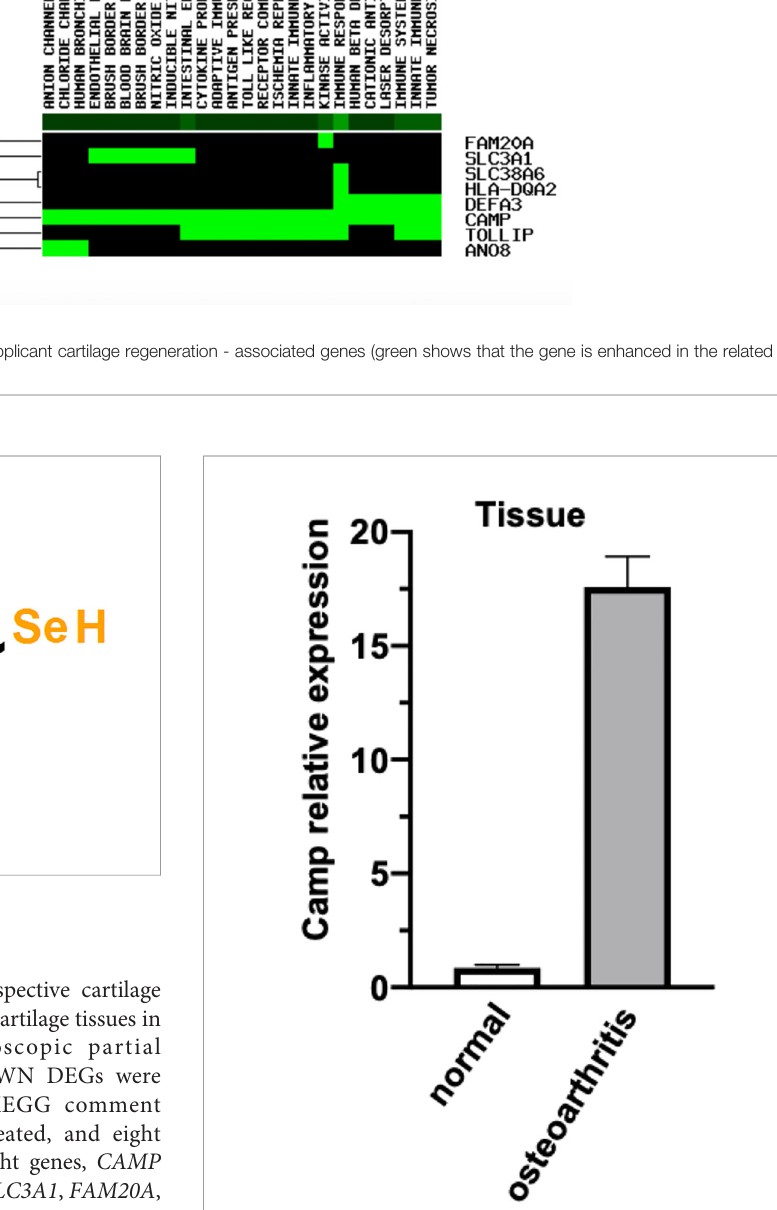
FIGURE 8 | The expression of CAMP transcripts differentially expressed between normal and osteoarthritis was validated by real-time PCR. The data is presented as mean with standard error of the